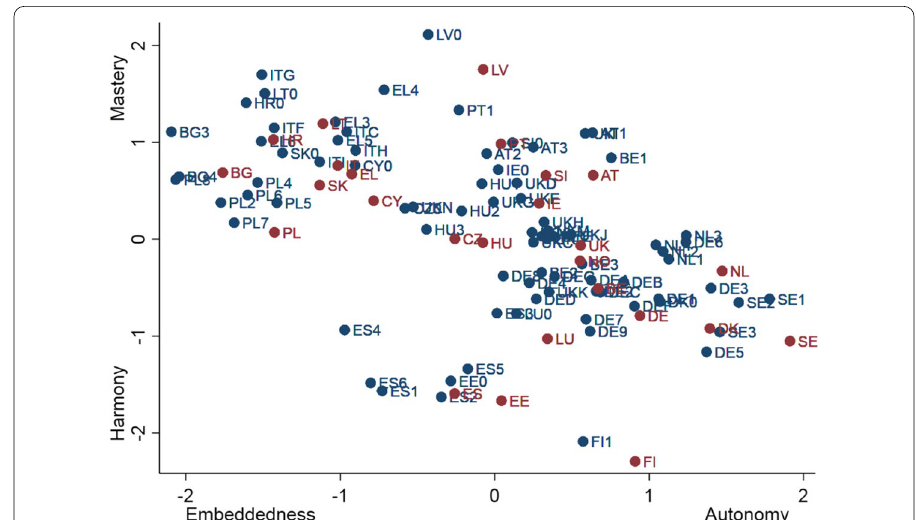
Fig. 1 Scatterplot of autonomy–embeddedness and mastery–harmony scores